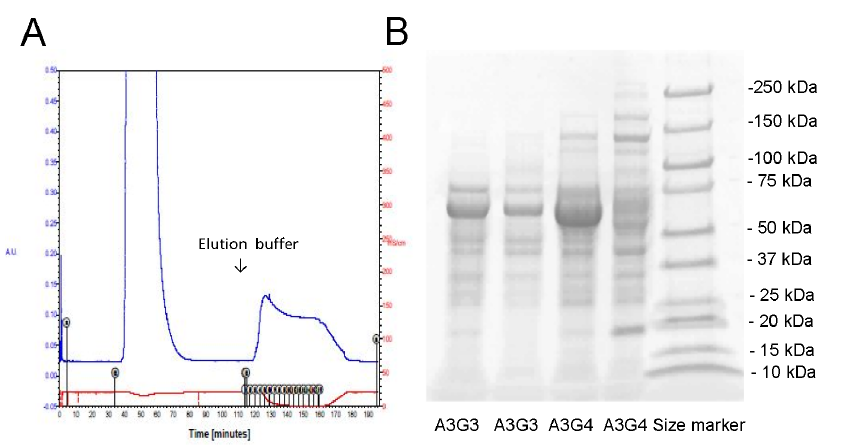
Figure 2. SSA-Agarose column choromatography performed in the 4 patients with type 2 diabetes. A . The concentrated urine samples were applied to SSA-Agarose column, washed with PBS and eluted with 0.2 M lactose. B . The effluents from the patients manifested with various albuminria and GFR stages, A3G3 and A3G4, were subjected to SDS-PAGE and stained with Coomassie Brilliant Blue. The bands were visualized and they were subjected to liquid chromatography-tandem mass spectrometer (LC/MS-MS) analysis.